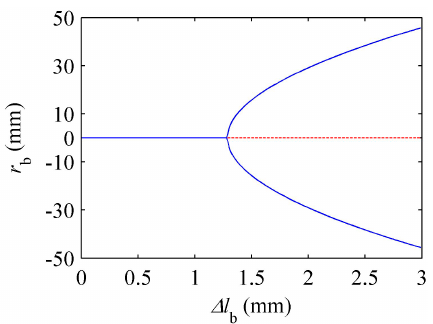
Figure 5. The equilibrium position of the loading piezoelectric actuator ( k b = 10 kN/m). The dashed line denotes unstable equilibrium